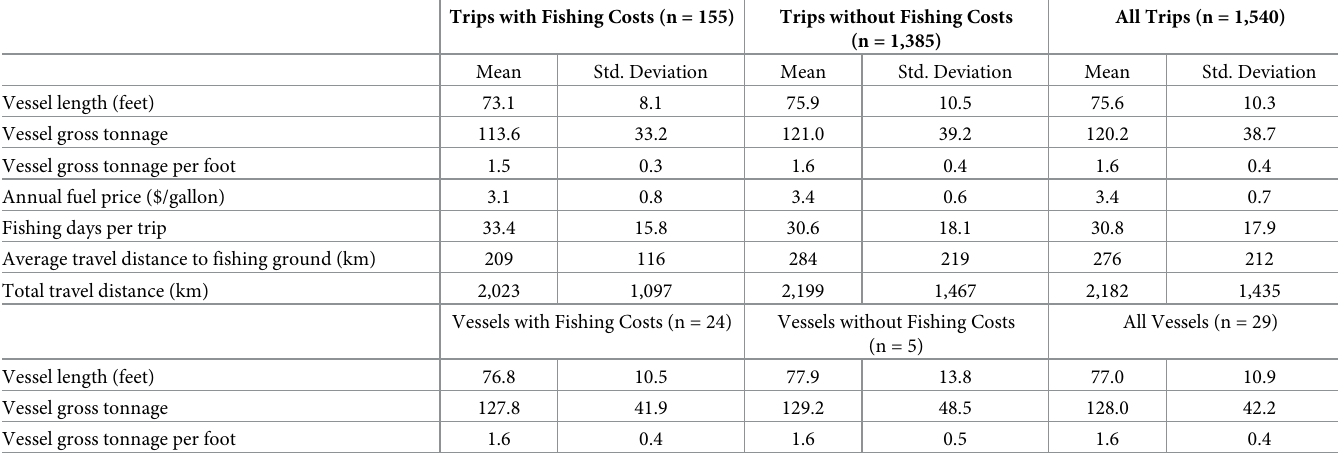
Table 2. Summary statistics of the covariates in American Samoa longline